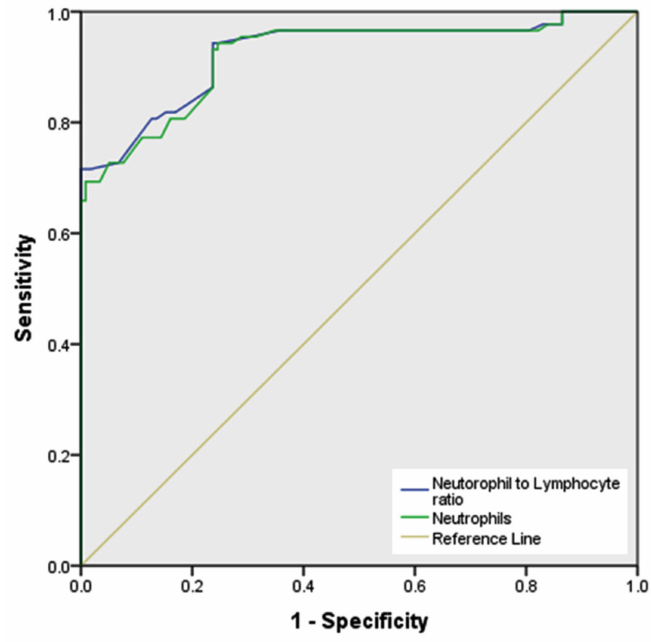
Figure 3. Receiver operating characteristic (ROC) curve for the predictive ability of neutrophil count and neutrophil–lymphocyte ratio (NLR) for the PCOS-associating subclinical inflammation. Cut-off values of neutrophil count and NLR are >46.62 (sensitivity 94.32% and specificity 74.42%), and >1.23 (sensitivity 71.59% and specificity 100%), respectively. Neutrophil area under the curve (AUC) was 0.922 and Youden index was 0.697. AUC for NLR was 0.926 and Youden index was 0.716. Comparative ROC z-statistic value was 2.222, and p = 0.026.